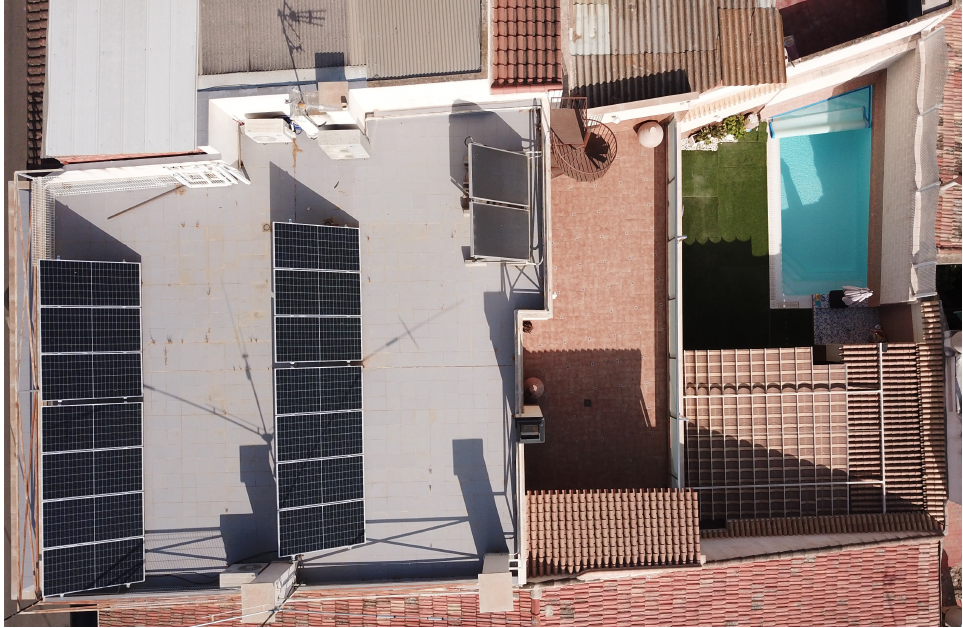
Figure 13. Aerial view of the test-bed location. Pool, PV panels, HVAC and heating units